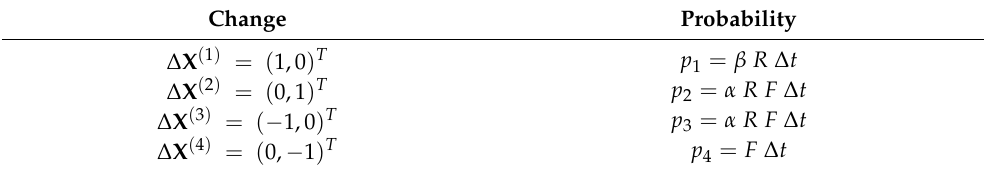
Table 1. Population changes and their